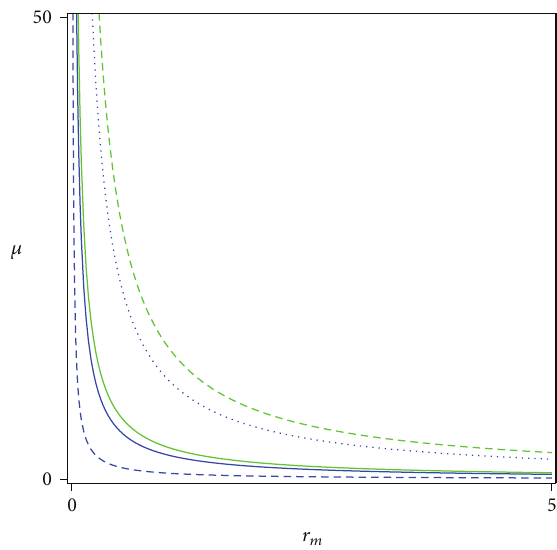
Figure 2: 𝜇 in terms of 𝑟 𝑚 : 𝐵 = 0.5 and 𝑎 = 2 (blue dashed line), 𝐵 = 1 and 𝑎 = 2 (blue solid line), 𝐵 = 2 and 𝑎 = 2 (blue dotted line), and 𝐵 = 1 and 𝑎 = 0.2 (green dashed line), and 𝐵 = 1 and 𝑎 = 0.4 (green solid line).